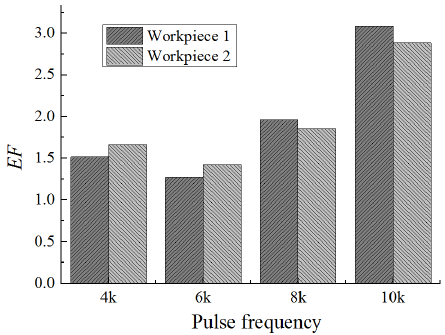
Figure 12. The EF of micro dimples generated with different pulse frequencies.